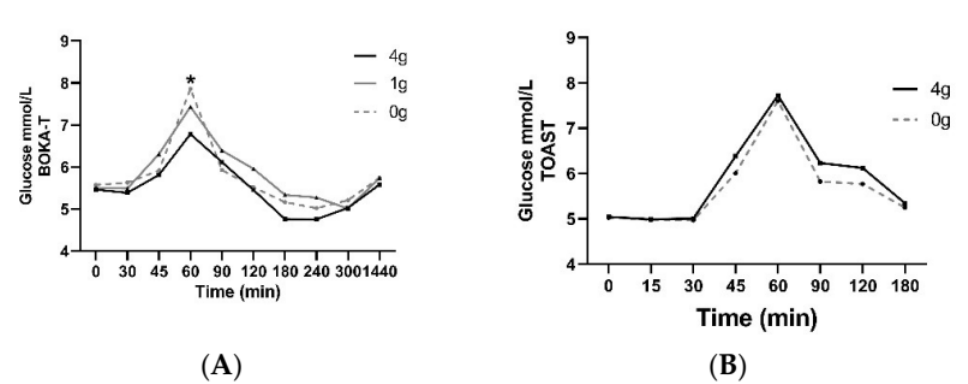
Figure 2. Mean ± SEM plasma concentrations of glucose for BOKA-T ( A ) and TOAST ( B ) throughout the postprandial period; 0 g (only hot water), 1 g (1 g kawakawa/250 mL hot water) and 4 g (4 g kawakawa/250 mL hot water). Differences between the treatment group over the postprandial were determined using repeated-measures ANOVA (* indicates p ≤